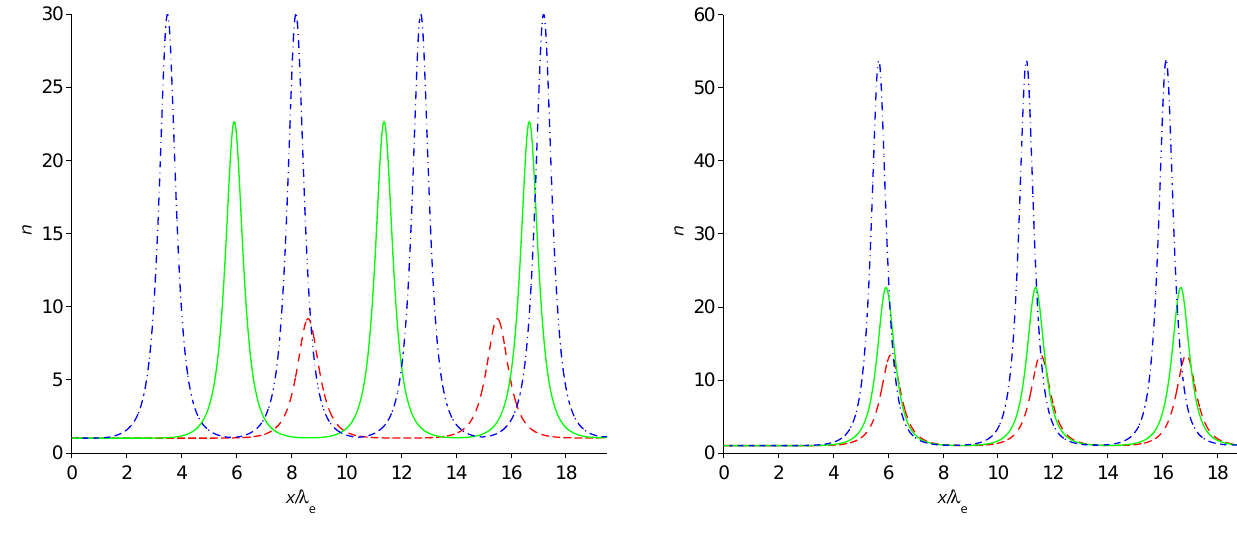
Fig. 5. The curves show normalized plasma density associated with Fig. 6. The curves show normalized plasma density associated with solitary waves propagating along the x -axis at 84 ◦ angle to B 0 with solitary waves propagating at M = 0 . 0025 along the x -axis at 81 ◦ M = 0 . 001 (red “- -”), M = 0 . 0025 (green “–”) and M = 0 . 0027 (red “- -”), 84 ◦ ) (green “–”) and 87 ◦ (blue “- · ”) angle to B 0 . The x -axis is normalized to electron inertial length, λ e . All structures (blue “- · ”). The x -axis is normalized to electron inertial length, λ e . All structures propagate in the plasma defined by Table 1 with propagate in the plasma defined by Table 1 with speeds close to the √ =√ βγ/ 2) relative to the βγ/ 2) relative to the speeds close to the ion-sound speed ( M = ion-sound speed ( M plasma.